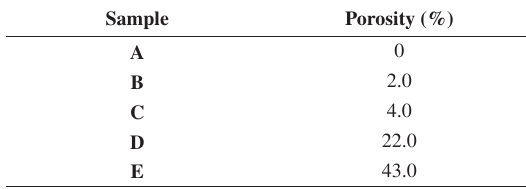
Table 2. Porosity of PMMA/hBN composite